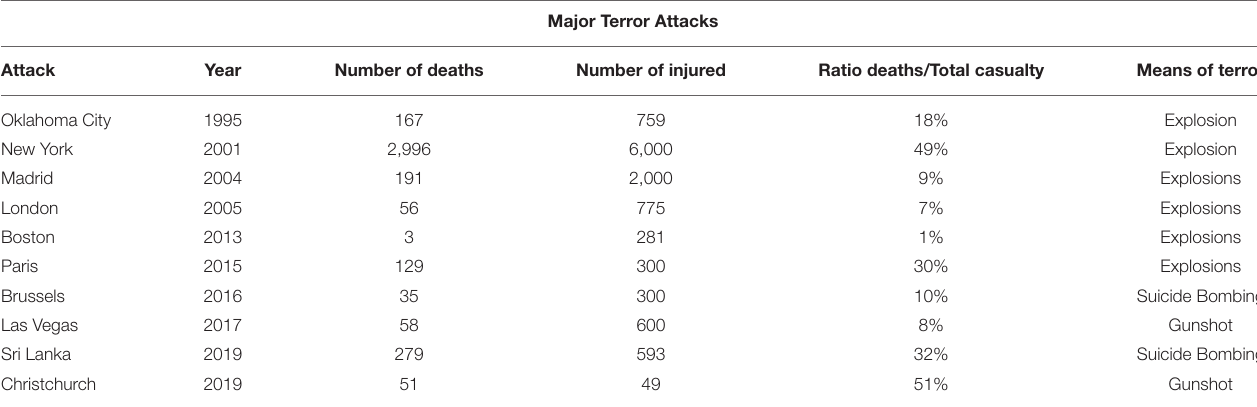
TABLE 2 | The outcome of some major terror attacks in terms of mortality and